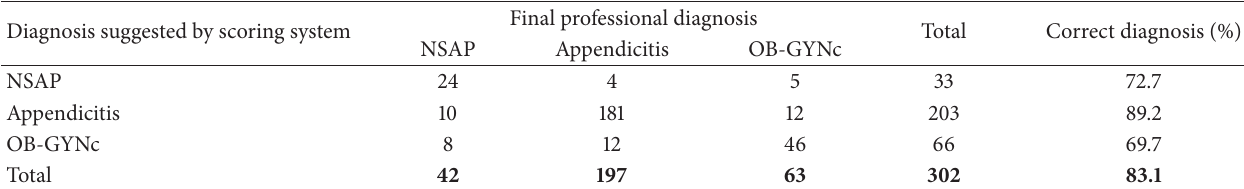
Table 4: Diagnosis suggested by the scoring system and final professional diagnosis in the validation data. Diagnosis suggested by scoring system